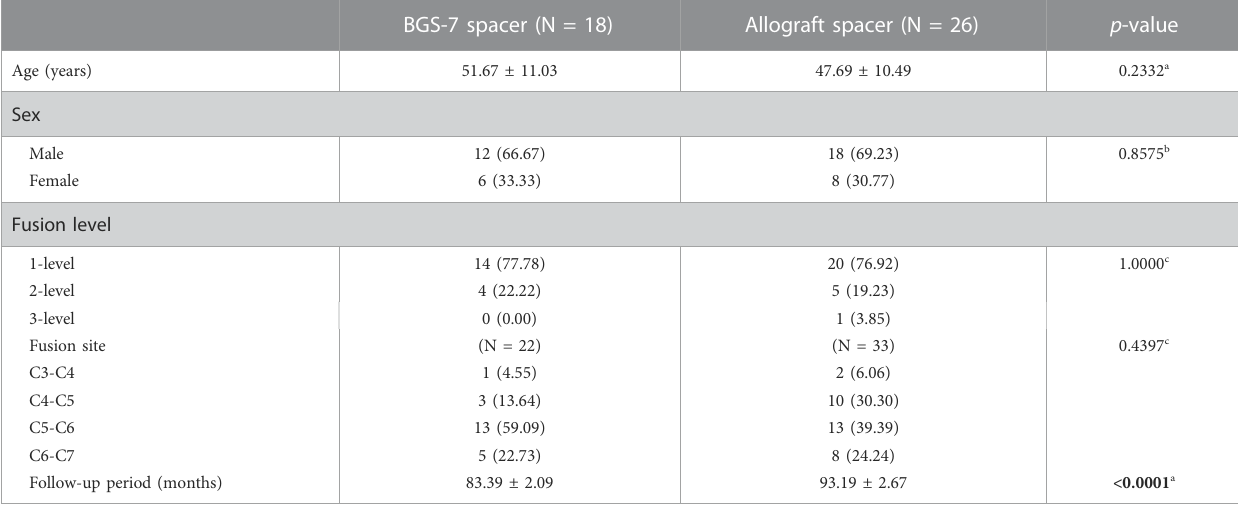
(Table 2) (Kumaresan et al., 1999; Kim et al., 2020; Kwak et al., 2021)